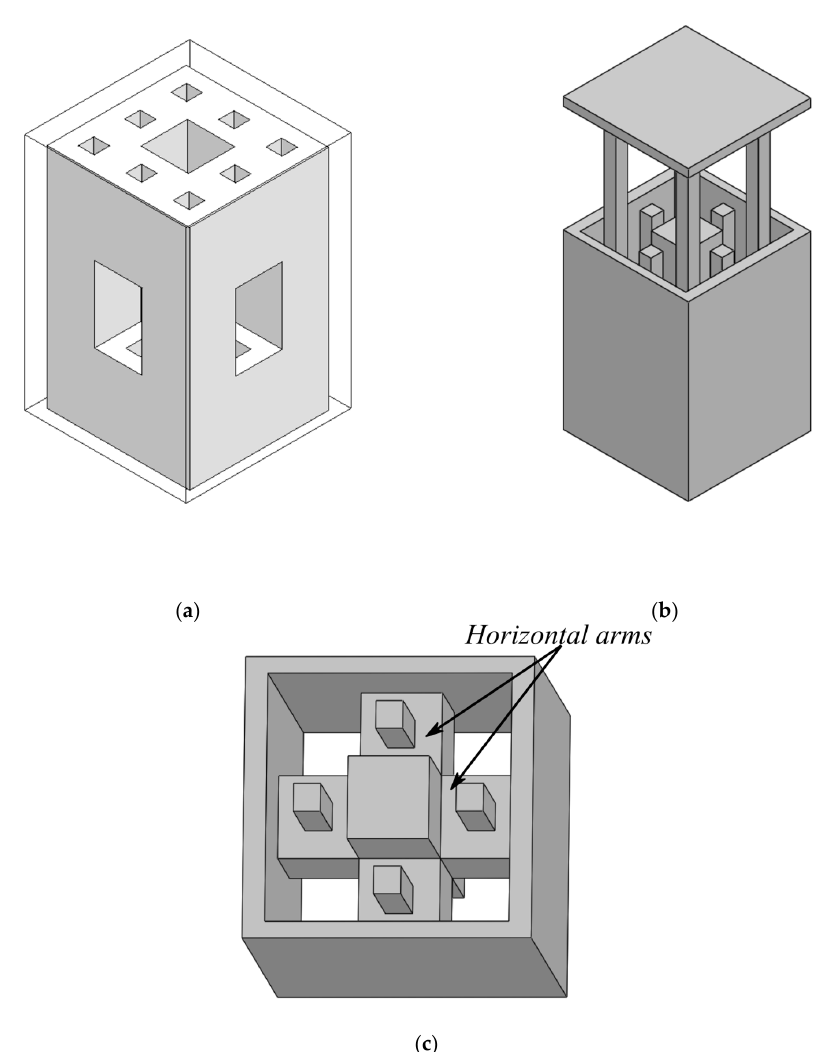
Figure 8. ( a ) Modified menger sponge fractal DRA structure. The dielectric paste is highlighted in white, whereas the outer part of the plastic mold is indicated by a solid line. As compared to the original menger sponge (see Figure 5), the hori ‐ zontal bars of the second iteration have been removed in order to allow for an easier fabrication. ( b ) Exploded view of the 3D ‐ printed mold structure, which is used for manufacturing process. The mold is split into two parts allowing for an easier manufacturing. The mold is then subsequently filled with the dielectric paste material. ( c ) Perspective view of the inside of the 3D ‐ printed mold showing the horizontal arms that give rise to the “holes” in the dielectric paste in ( a ). In order to analyze the operating mechanism of the circularly polarized antenna, the resonant modes inside the linearly polarized antenna, excited by a simple slot as shown in Figure 5, are characterized first. The electric field distribution of the modified menger sponge fed by a simple slot are shown in Figure 9a,b at their resonance frequencies at 2.45 GHz and 2.9 GHz (compare Figure 7), respectively. The field distributions at 2.45 GHz indicate that the DRA operates in its fundamental TE δ 11 mode. At 2.9 GHz, the field distri ‐ butions resemble those of the TE δ 13 mode.